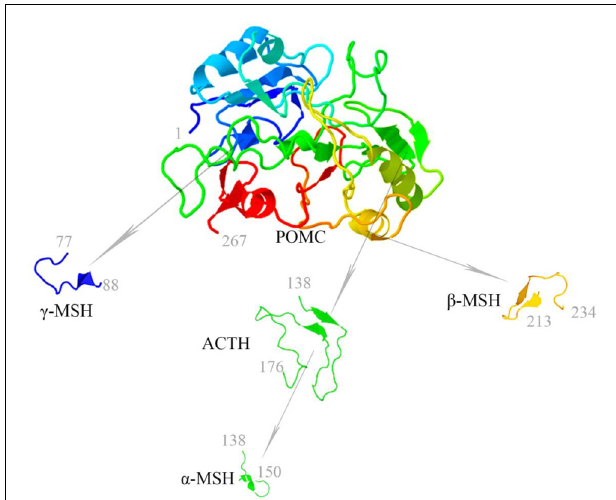
FIGURE 1 | Melanocortin peptides (ACTH, α -MSH, β -MSH, and γ -MSH) are all derived from the common precursor protein pro-opiomelanocortin (POMC). The 3-dimensional structure modeling of human melanocortin peptides was generated based on amino acid sequences by using the following two servers for automated protein structure modeling (http://protein.ict.ac.cn/FALCON/#focus; http://bioserv.rpbs.univ-paris-diderot.fr/services/PEP-FOLD/).